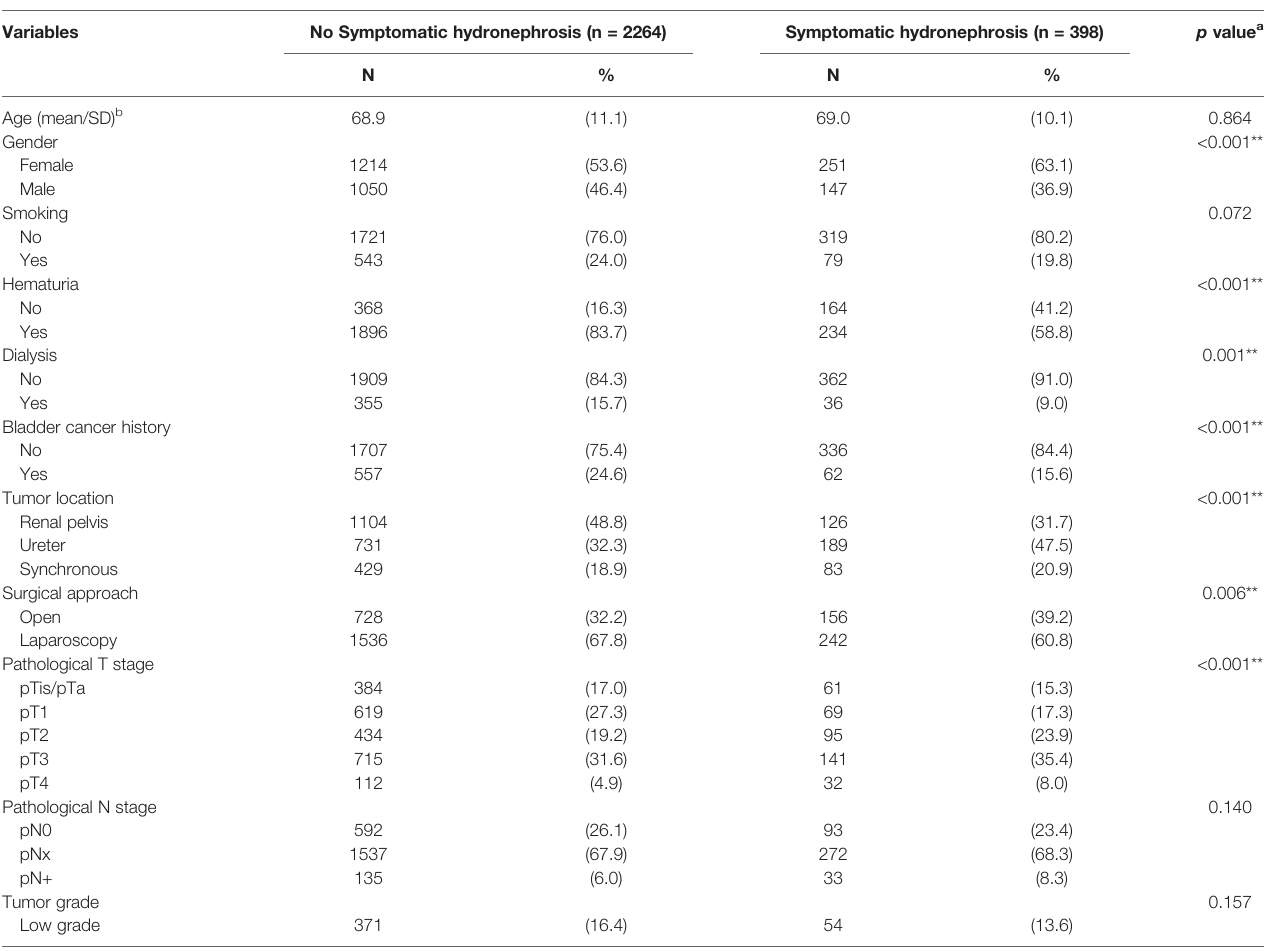
TABLE 2 | Clinicopathological data of UTUC patients according to symptomatic hydronephrosis.